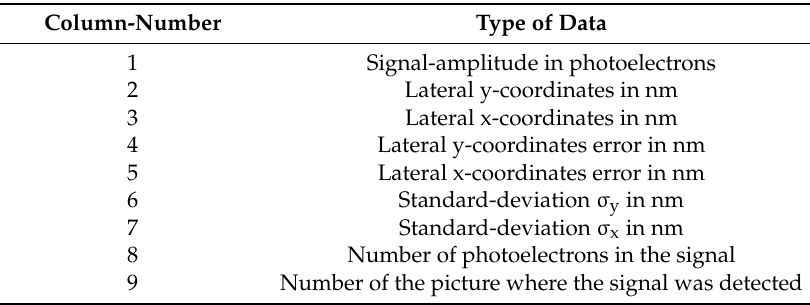
Table 2. Structure of the Localization Data Matrix.